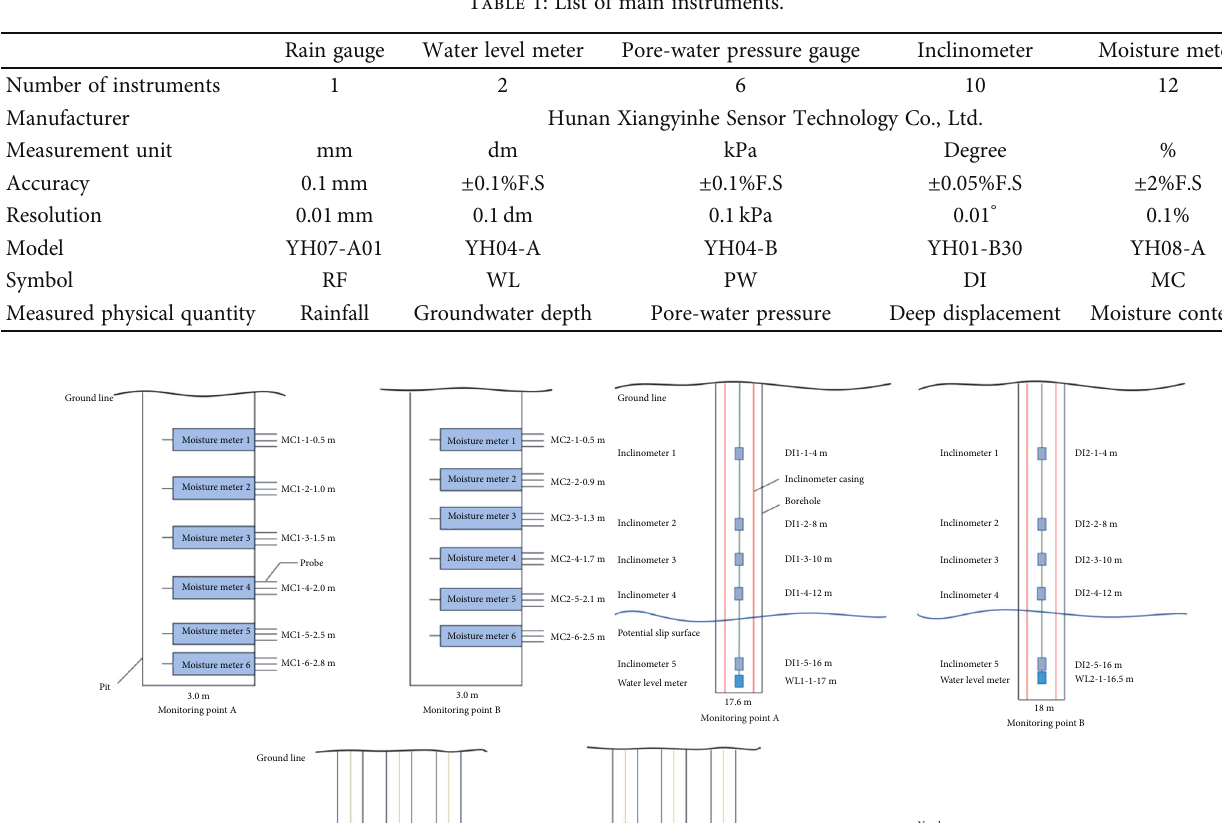
Table 1: List of main